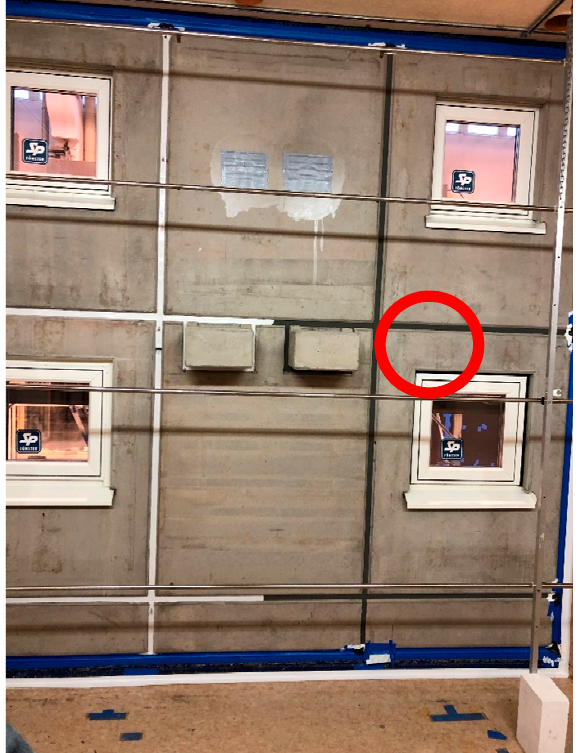
Figure 8. Laboratory concrete facade test setup, where the red circle marks the studied point A19 [19]. Table 6. Leakage in A19 from [19]. Two objects were studied in three testing rounds. The pressure steps according to the standard are given as well as the actual measured pressure over the joint sealing